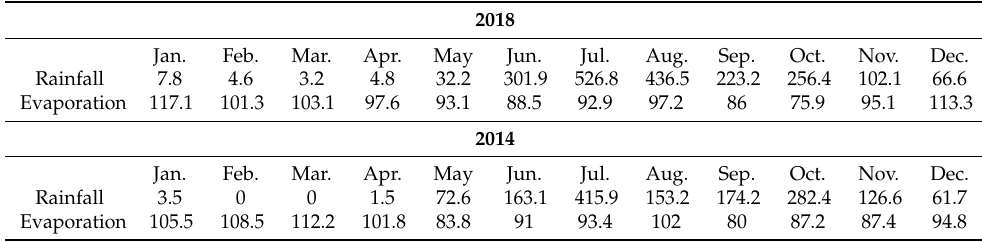
Table A2. The meteorological data—monthly rainfall and evaporation in Con Dao (unit: